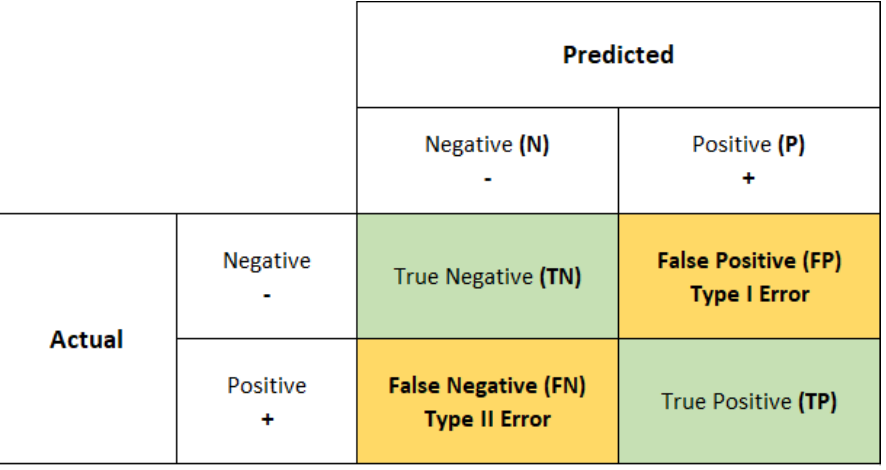
Figure 6. Confusion matrix for binary